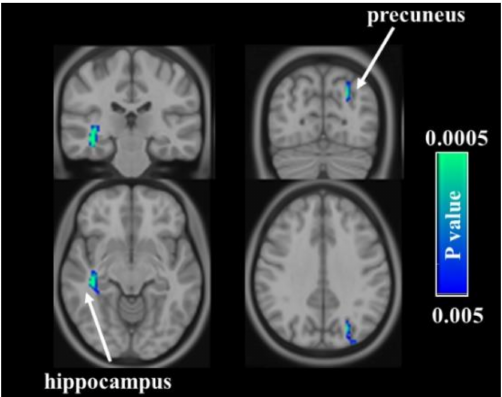
Figure 5. Regression analysis for the relationship between analgesic relevance and baseline cerebral blood flow (CBF). The higher baseline CBF in left precuneus and right hippocampus accompanied with worse treatment response in patients with primary